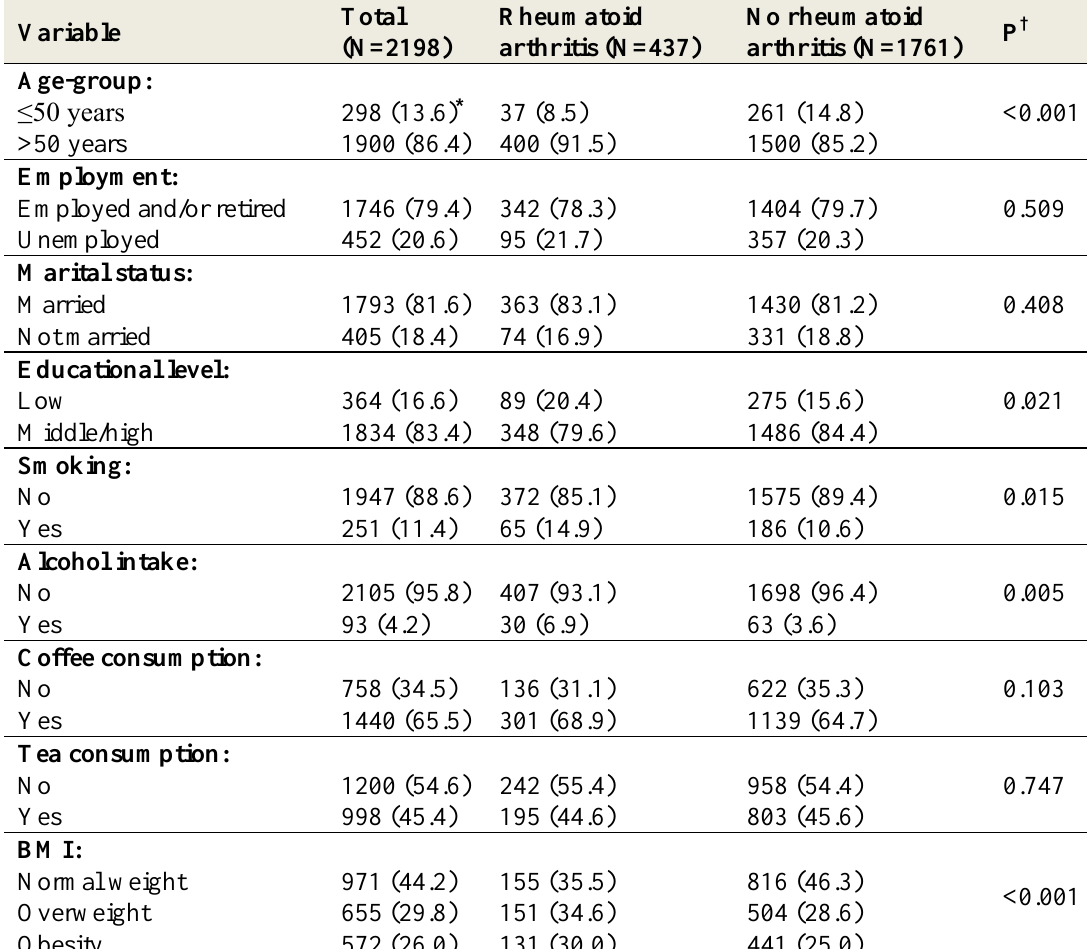
Table 1. Distribution of socio-demographic characteristics and lifestyle/behavioral factors in a sample of Albanian women by rheumatoid arthritis status Total Rheumatoid No rheumatoid Variable (N=2198) arthritis (N=437) arthritis